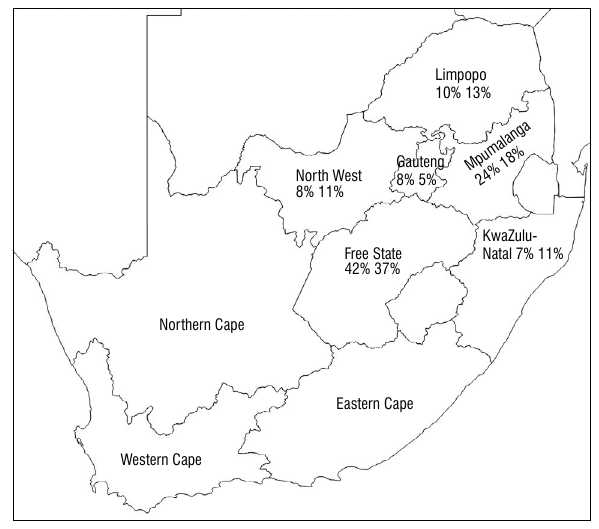
Dry bean production levels in the six main production provinces of South Africa during the 2008/2009 (left value) and 2010/2011 (right value) growing seasons.